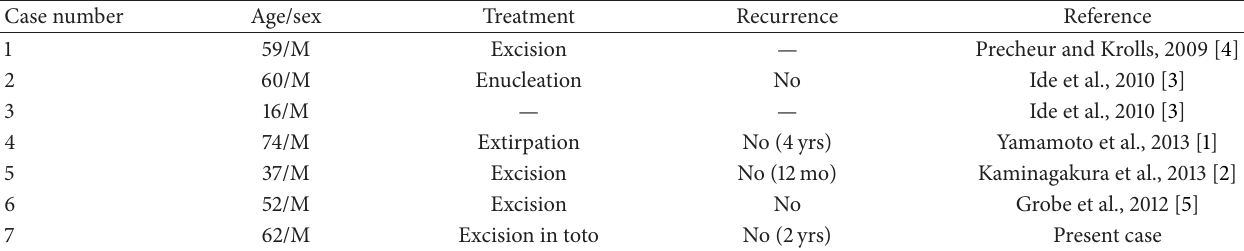
Table 1: List of all the reported cases of KCOT in the buccal mucosa.